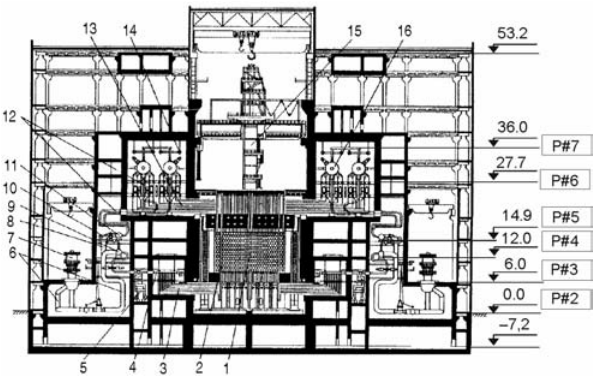
Fig. 1. Cross-section of the reactor building with